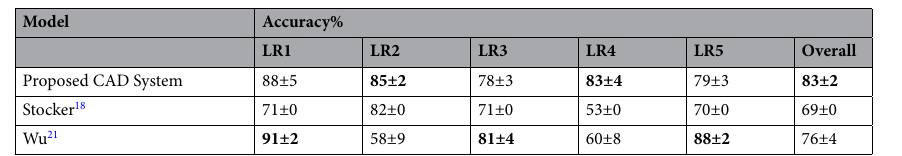
Table 8. The final diagnostic performance for grading the tumors into (LR1, LR2, LR3, LR4, and LR5) by using (a) the proposed CAD system, (b) approach by Stocker et al. 18 , and (c) approach by Wu et al. 21 .